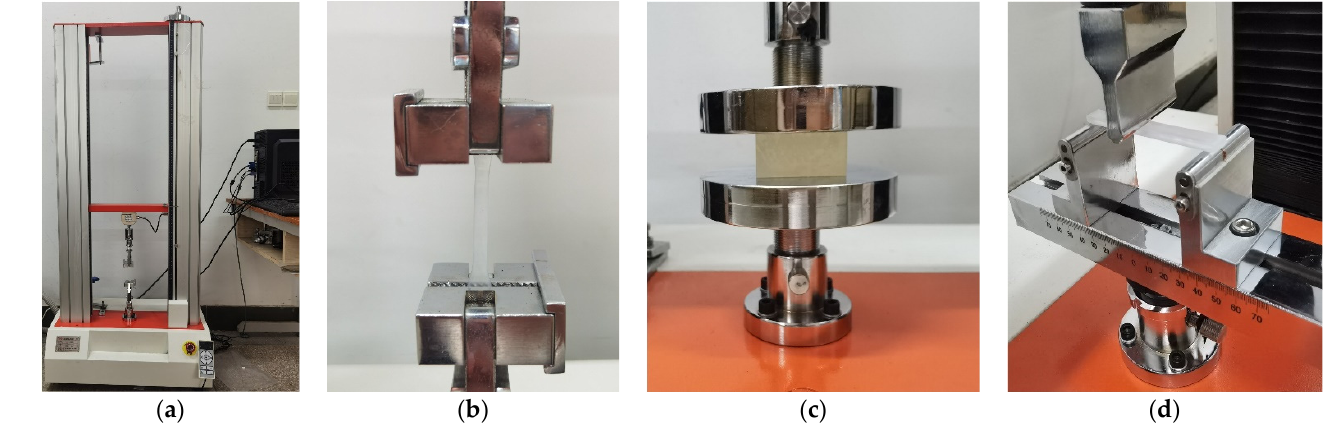
Figure 5. The detection of mechanical properties. ( a ) The universal testing machine; ( b ) detection of tensile strength; ( c ) detection of compressive strength; ( d ) detection of flexural modulus.